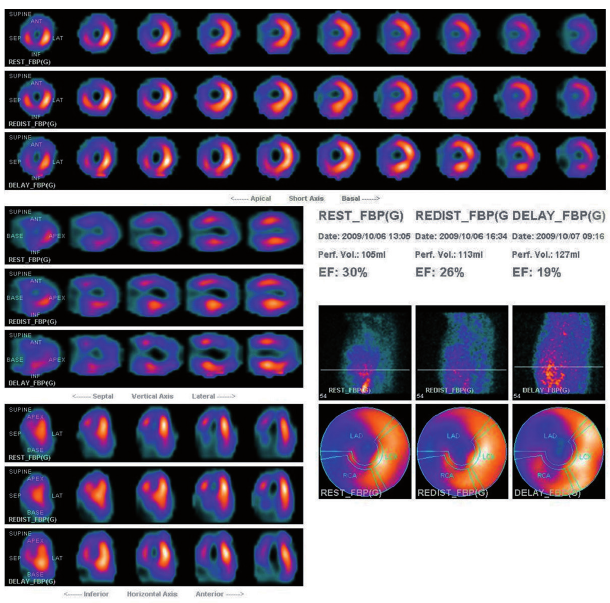
Fig. 1 - Short axis, vertical axis, horizontal axis, and bulls eye Tl- 201 MPS images of a patient who has viable tissue only in 24 hour images in septum and anteroseptal wall